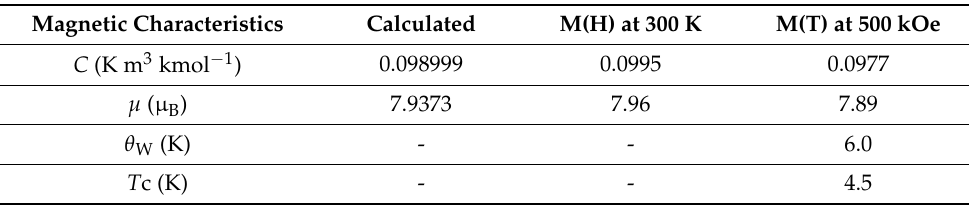
Table 6. Magnetic characteristics for EuScCuSe 3 .